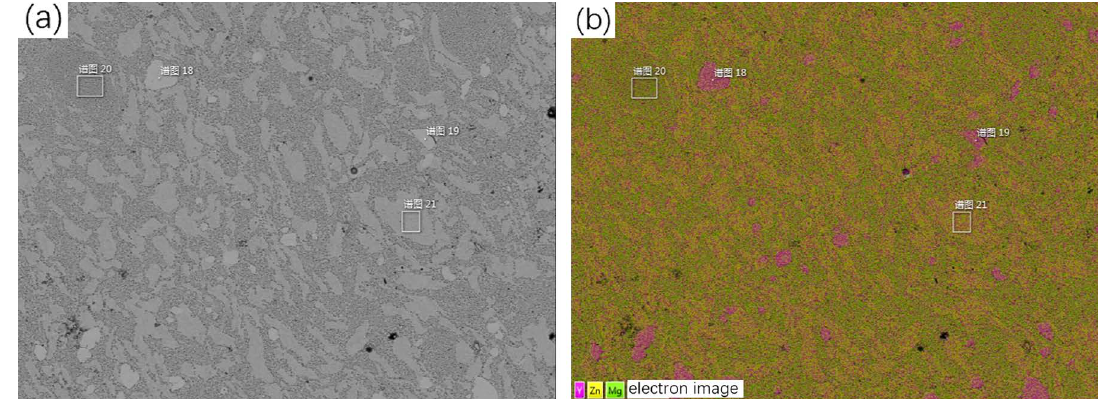
Figure 2. (a) SEM backscaterred electron image and, (b) EDS elemental map of the microstructure of Zn-1.5Mg-0.5Y